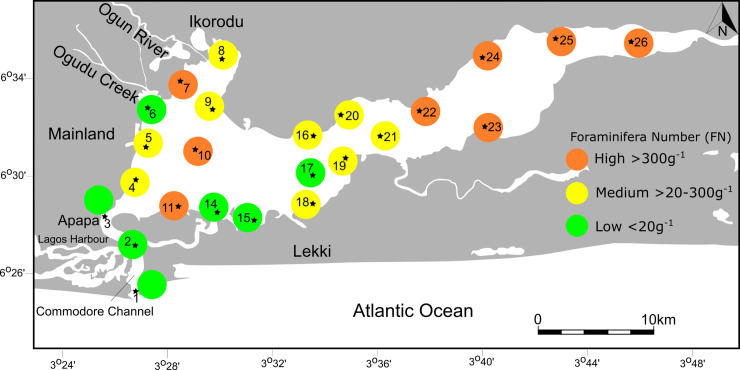
Number of foraminifera per unit gram of sediment (FN) in the Lagos Lagoon.Note consistently high values in the eastern sector medium to high values along the continuation of the Ogun River outflow.